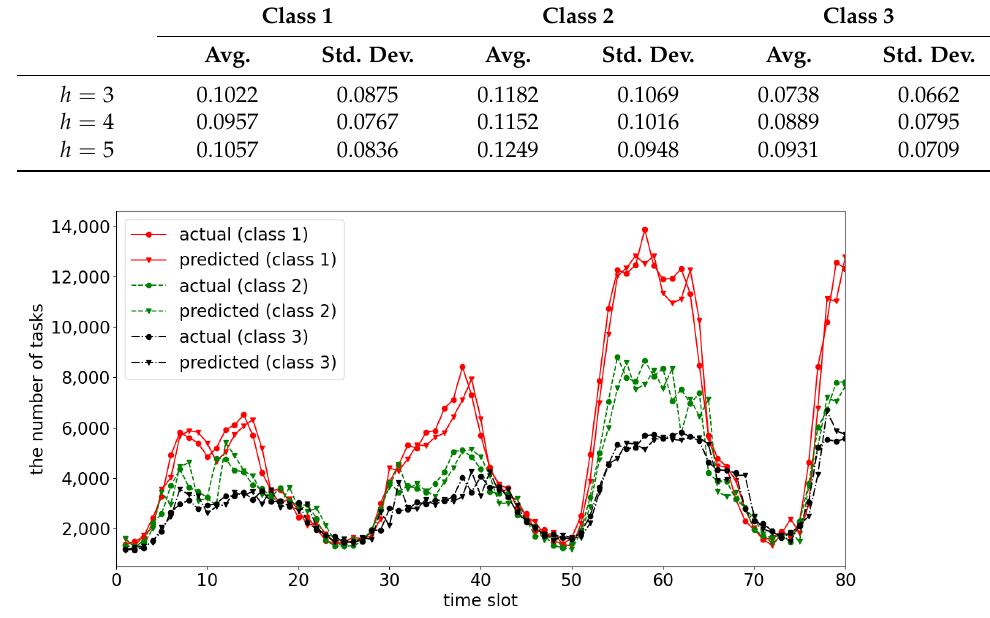
Figure 2. Comparison between actual and predicted